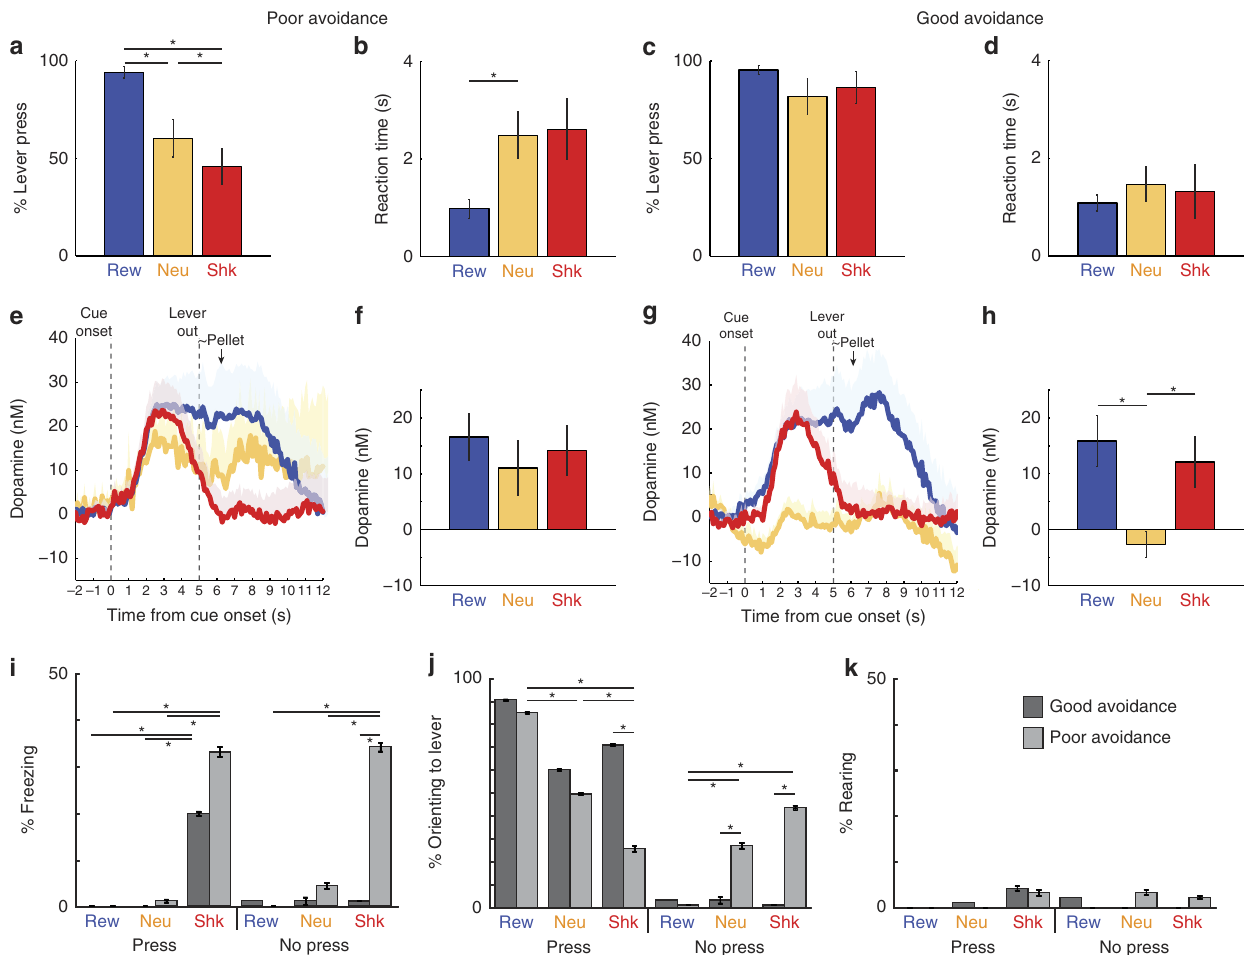
Figure 4 | Poor and good avoidance exhibit differences in behaviour and dopamine release across trial types. Reward, neutral, and shock trial types are represented by blue, yellow, and red, respectively. Behavioural differences are shown using percent lever press ( a ) and reaction times ( b ) for poor avoidance and percent lever press ( c ) and reaction times ( d ) for good avoiders. Bars with asterisks represent significance ( T -test; P o 0.05; n ¼ 6 rats for good avoidance, 5 rats for poor avoidance). Error bars represent s.e.m. ( e – h ) Dopamine quantification for poor and good avoiders. Dopamine release (nM) for each trial type is shown across time with cue and lever epochs indicated for poor ( e ) and good avoiders ( g ), respectively. Dopamine release is quantified during the cue epoch for each trial type for poor ( f ) and good ( h ) avoiders. Error bars represent s.e.m. ( i – k ) Analysis of stress-related behaviours during press and failed press. Percent freezing ( i ), orienting to the lever ( j ), and rearing ( k ) during poor and good avoidance. Asterisks indicate P o 0.05 in chi-square; n ¼ 6